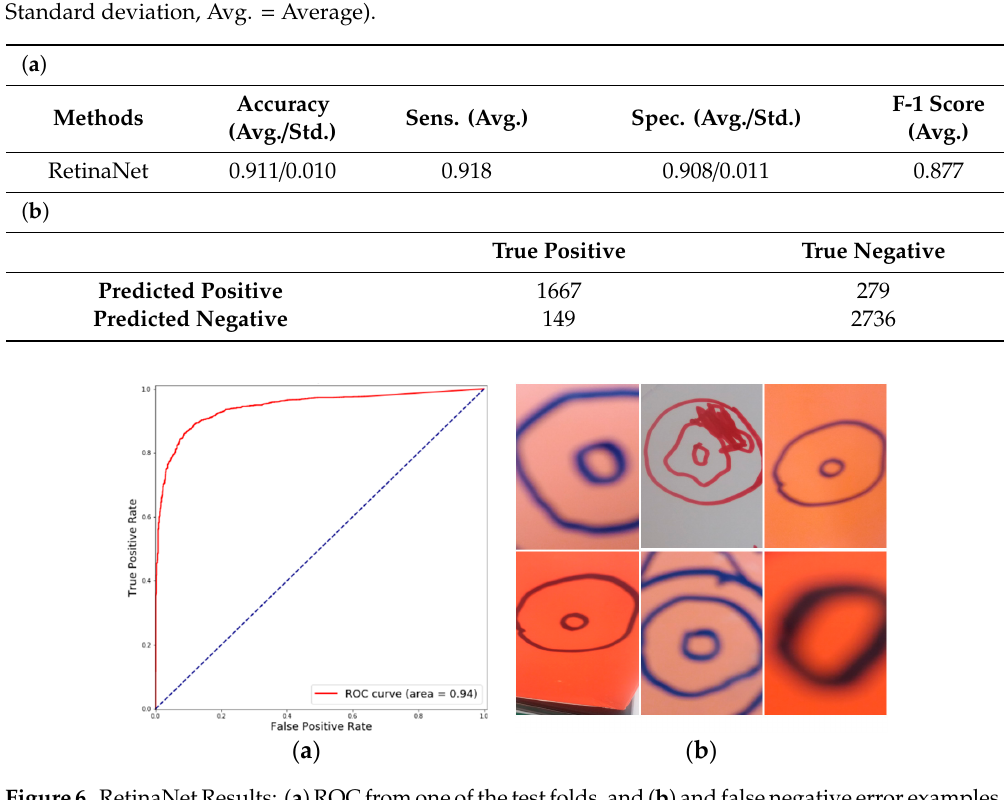
Figure6. RetinaNetResults: ( a )ROCfromoneofthetestfolds, and( b )andfalsenegativeerrorexamples. Figure 6. RetinaNet Results: ( a ) ROC from one of the test folds, and ( b ) and false negative error examples.